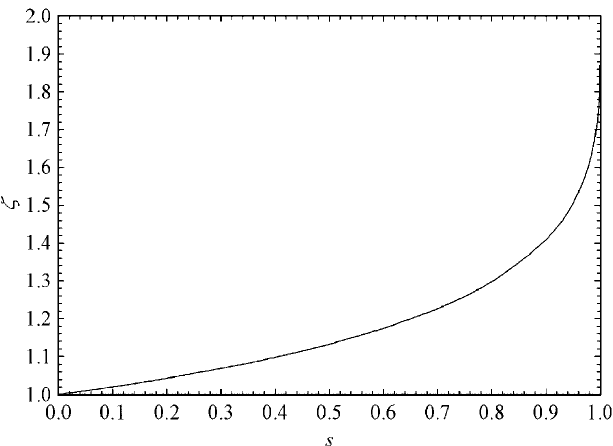
(cid:6) r (cid:7) is determined b (cid:6) 0 (cid:7) (cid:1)R 2 (cid:11) is plotted = (cid:10) n b b b